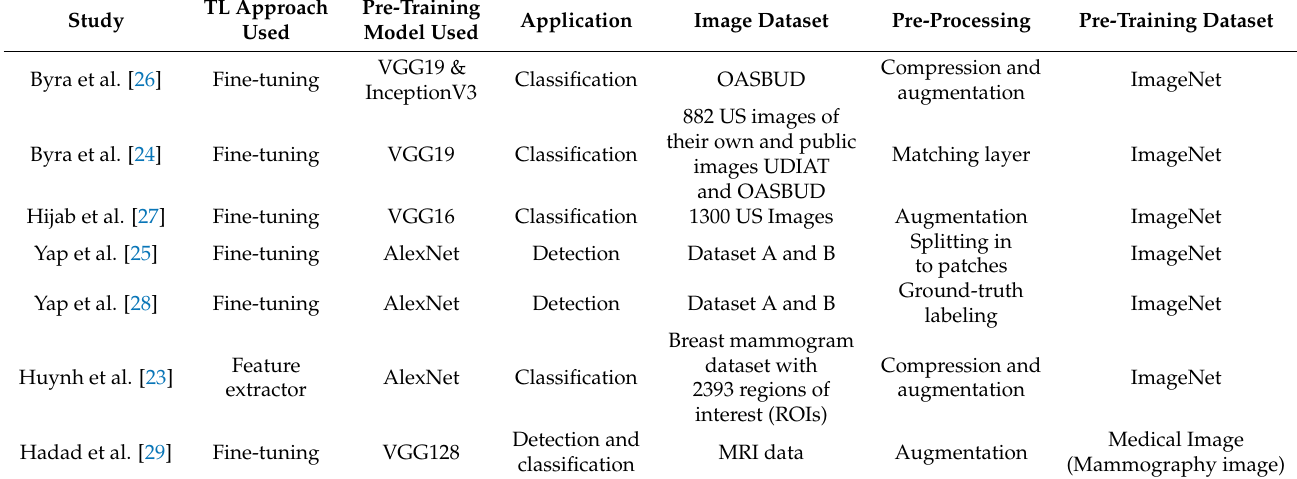
Table 1. Summary of previous transfer learning (TL) approaches for breast cancer diagnosis using ultrasound. OASBUD, open access series of breast ultrasound data; US, ultrasound; UDIAT, UDIAT Diagnostic Centre of the Parc Tauli Corporation ultrasound image data; dataset A, ultrasound images obtained with BK Medical Panther 2002 and BK Medical Hawk 2102; dataset B, UDIAT Diagnostic Centre of the Parc Tauli Corporation ultrasound image